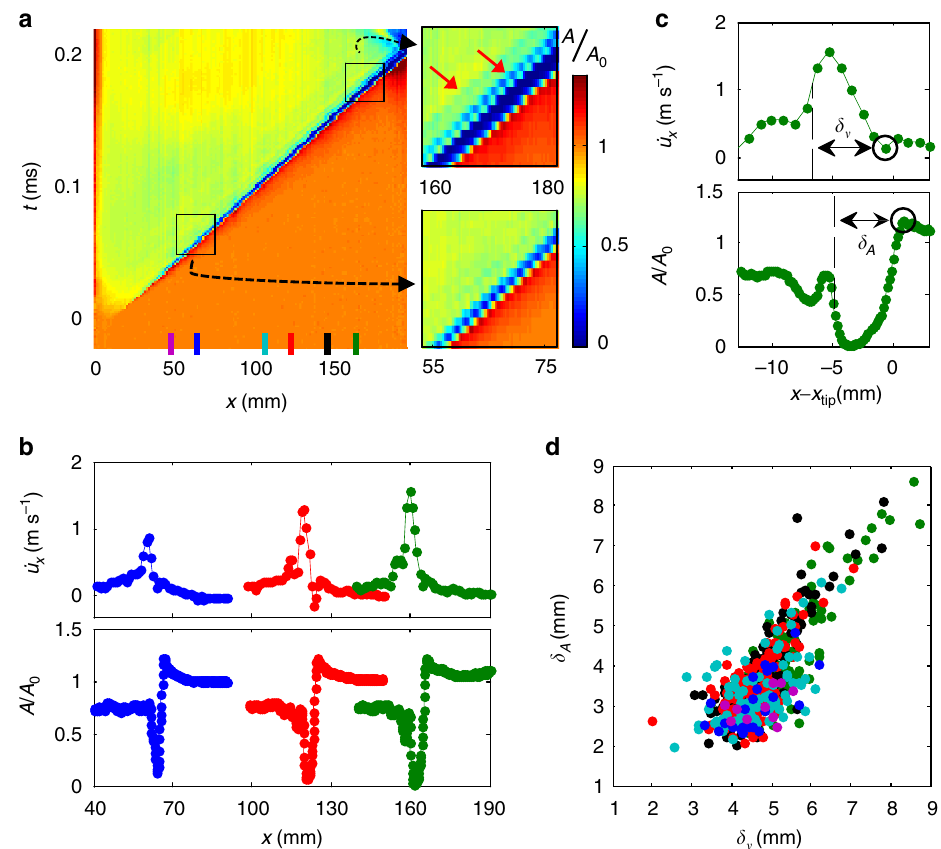
Figure 3 | Slip-pulses continuously evolve with propagation. ( a ) A ( x , t ) of a typical front in the positive direction. Right panels are close-ups of A ( x , t ) in the marked areas. Red arrows denote secondary and tertiary slip-pulses that follow the main slip-pulse which are absent during the earlier (55–75mm) propagation. ( b ) _ u x ( x ) (top) and A ( x ) (bottom) profiles along the interface. Each profile is displayed around x tip locations coinciding with the strain gauge locations (coloured lines) denoted in a . ( c ) Close-ups of _ u x ( x (cid:2) x tip ) (top) and A ( x (cid:2) x tip ) (bottom) for x tip ¼ 165mm. We define pulse widths; d v is defined from the point where _ u x becomes positive (circle), to 2/3 of the difference between maximal and residual values (Methods). d A is defined from the point of maximal compression of A ( x (cid:2) x tip ) (circle) to 1/3 of the difference between its residual and minimal values. ( d ) d A versus d v for 131 fronts for 2,000 o F N o 6,000N. Colours: locations denoted in a .